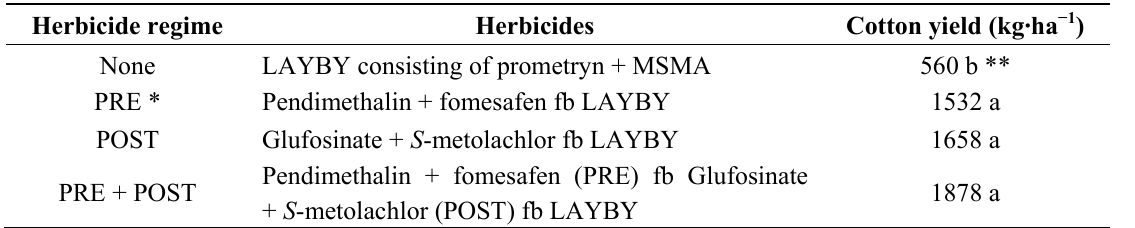
Table 7. Influence of herbicide regimes on cotton yield with cover crop, soil-inversion, and three production years’ data